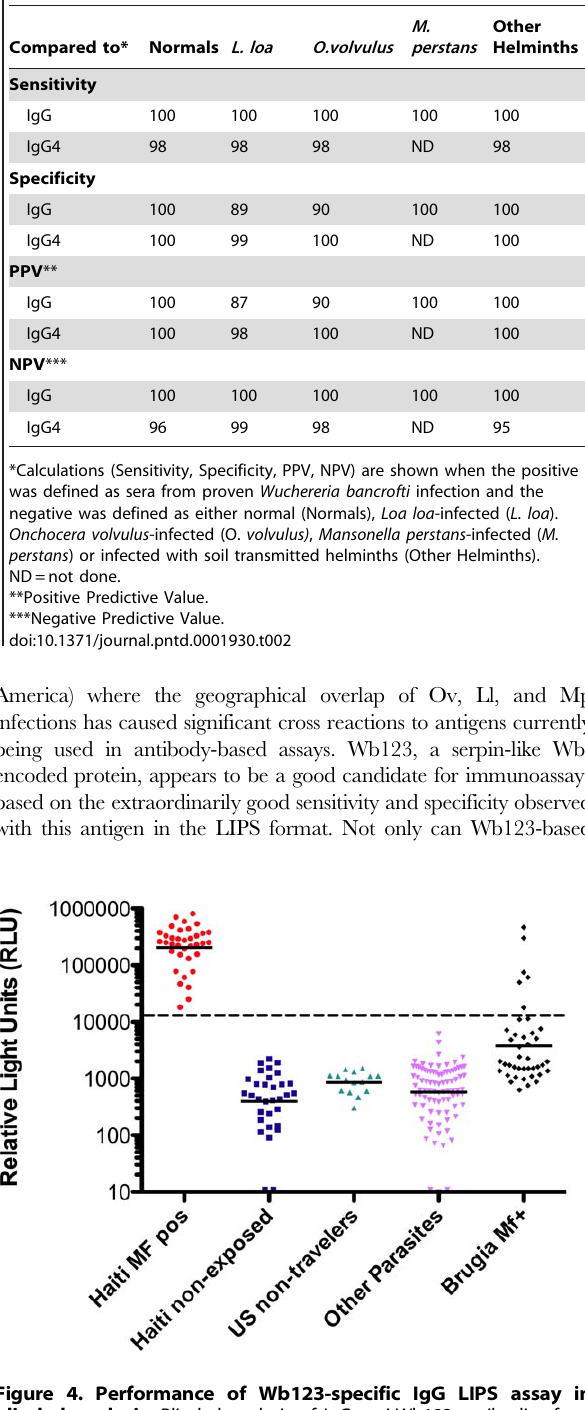
Figure 4. Performance of Wb123-specific IgG LIPS assay in blinded analysis. Blinded analysis of IgG anti-Wb123 antibodies from samples obtained from Wuchereria bancrofti -infected patients from Haiti (Haiti MF pos), those from a Wb non-endemic region of Haiti (Haiti non- exposed), US non-travelers, those with other non-filarial parasitic infection, or those with Brugia malayi infection. Each dot represents an individual subject and the horizontal line is the GM. The dashed line represents the cutoff between negative and positive based on ROC analysis.